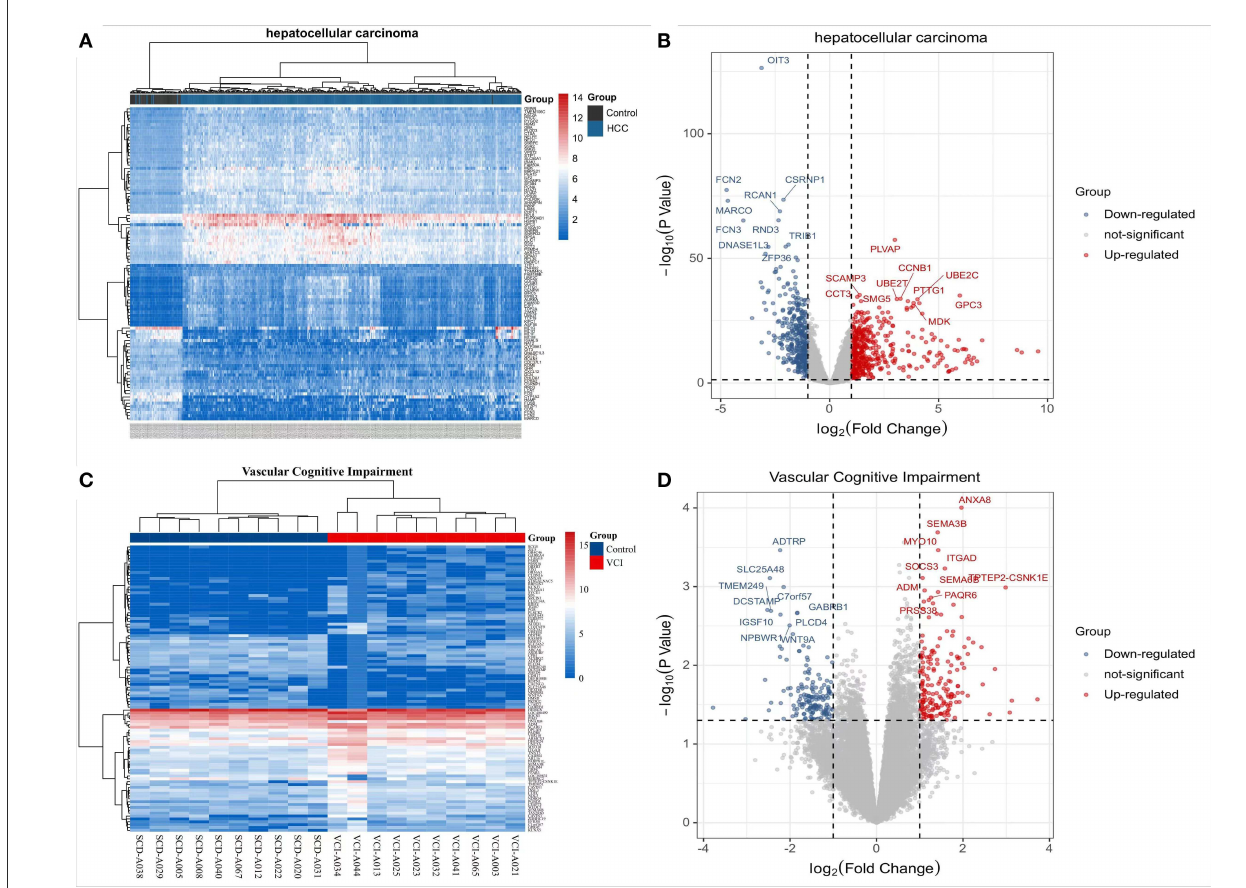
FIGURE2 Transcriptomic analysis of HCC and VCI. (A) Heat map of DEGs clustering for HCC transcriptomics; (B) Transcriptomics of DEGs volcanoes for HCC; (C) Heat map of DEGs clustering for VCI transcriptomics; (D) Volcano map for VCI transcriptomics based on